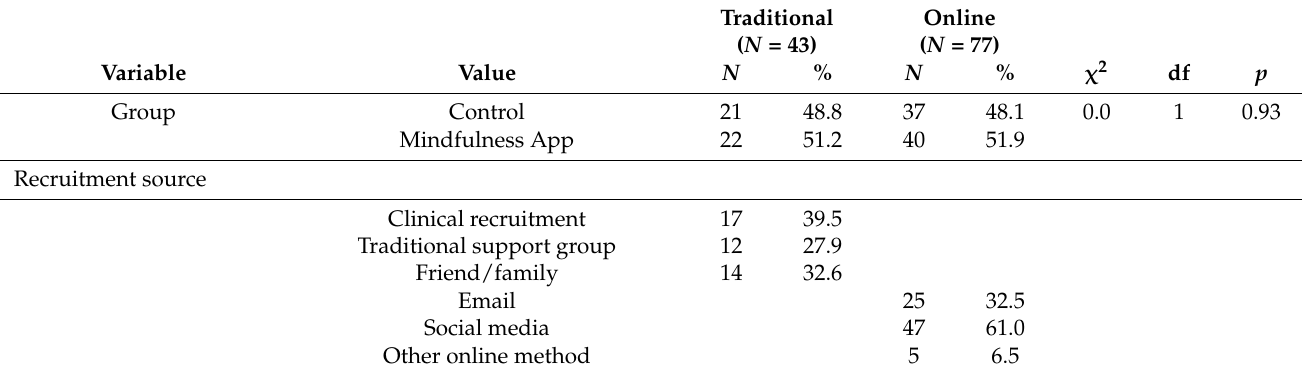
Table 1. Participant demographics and clinical characteristics by recruitment